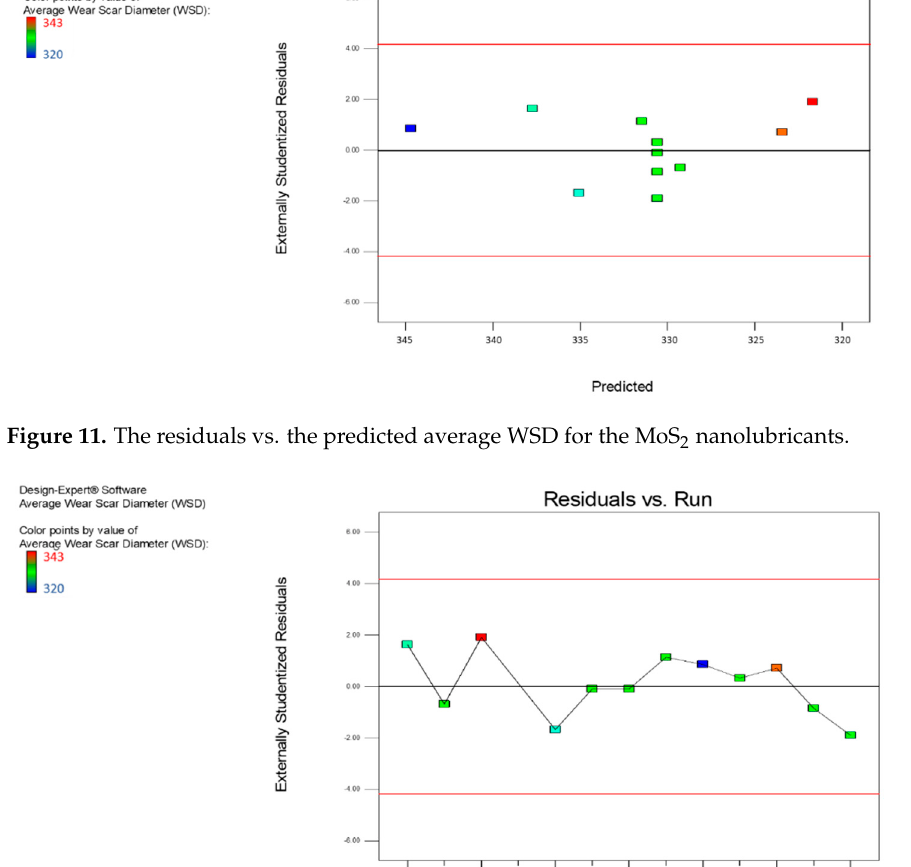
Figure 12. The residuals vs. the experimental run of the average WSD for the MoS 2 nanolubricants.